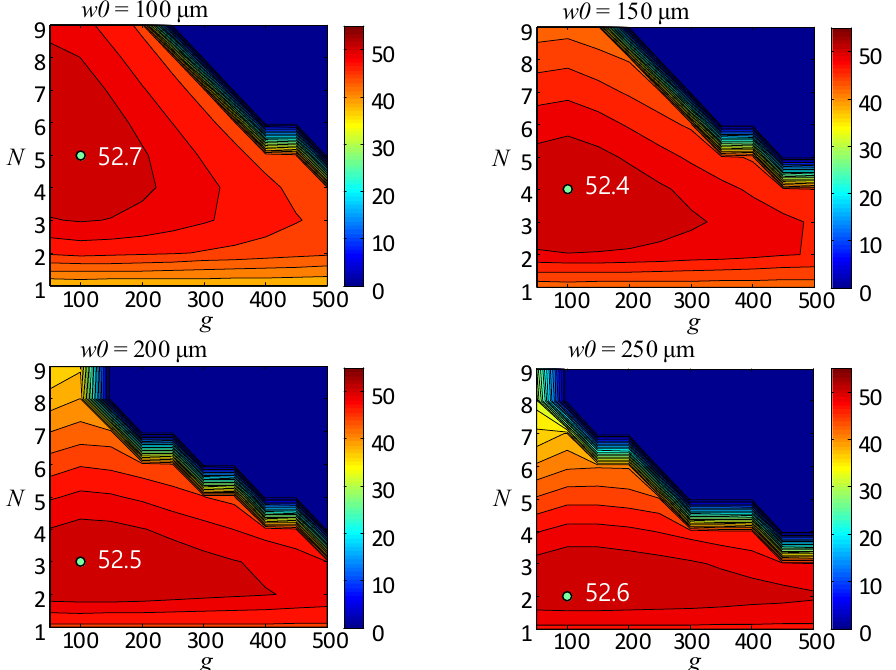
Figure 13. The calculated maximum coupling efficiency (%) according to g and N for the four-layer planar spiral coil for w 0 = 100, 150, 200, and 250 μ m.